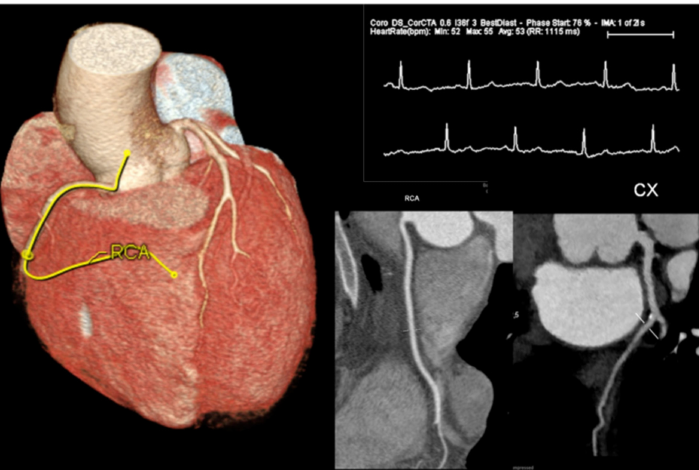
Figure 4. A 48-year-old male with intermediate risk of CAD and atypical chest pain. Cardiac gated CT showed no coronary stenosis, and the patient was safely